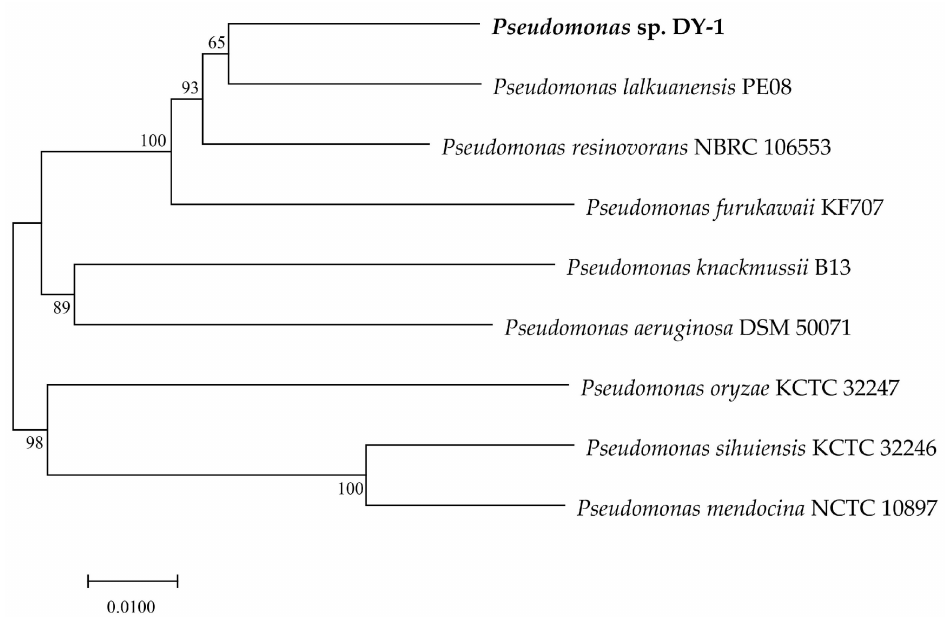
Figure 4. Phylogenetic tree based on the 4-genes MLSA for Pseudomonas sp. DY-1 and other eight type strains. The distance matrix was calculated by the Jukes-Cantor method. The dendrogram was generated by neighbor-joining. Branches corresponding to partitions reproduced in more than 50% bootstrap replicates (from 1000 replicates) are shown with the bootstrap value at the